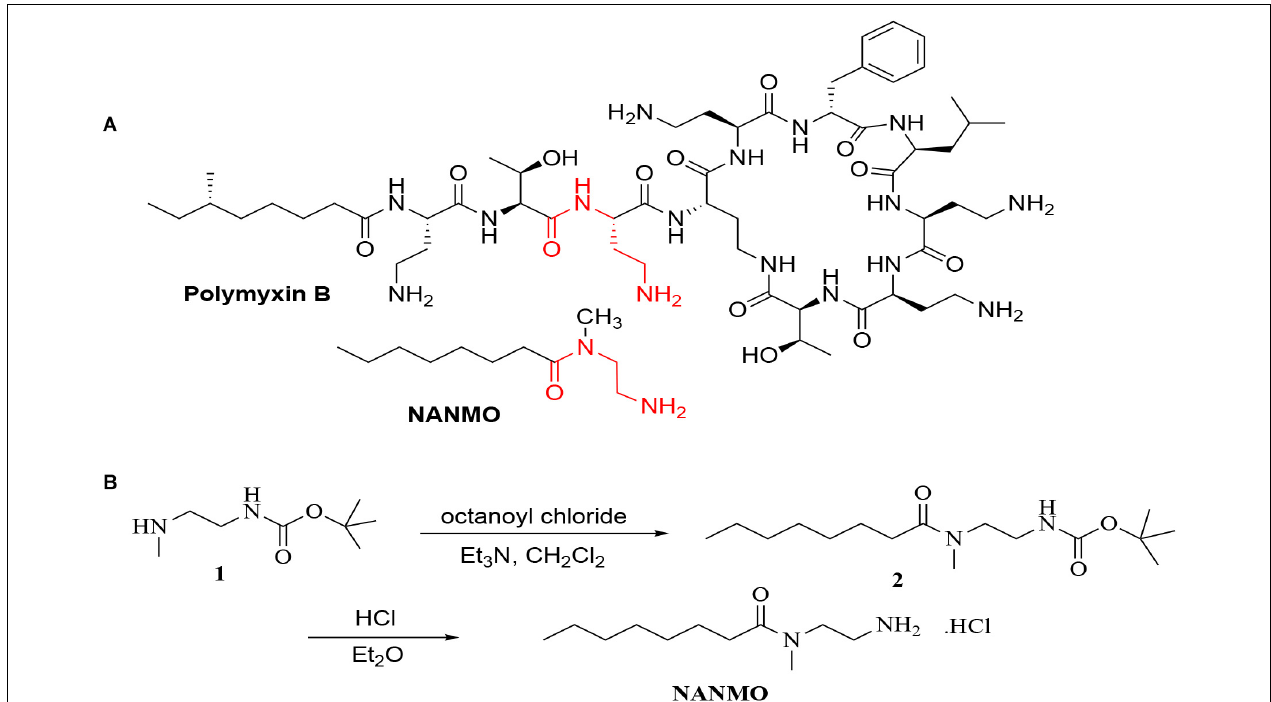
FIGURE 1 | (A) The structures of polymyxin B and NANMO. The 3-Dab of polymyxin B is shown in red. The common substructures of NANMO and polymyxin B are shown. (B) The synthesis of